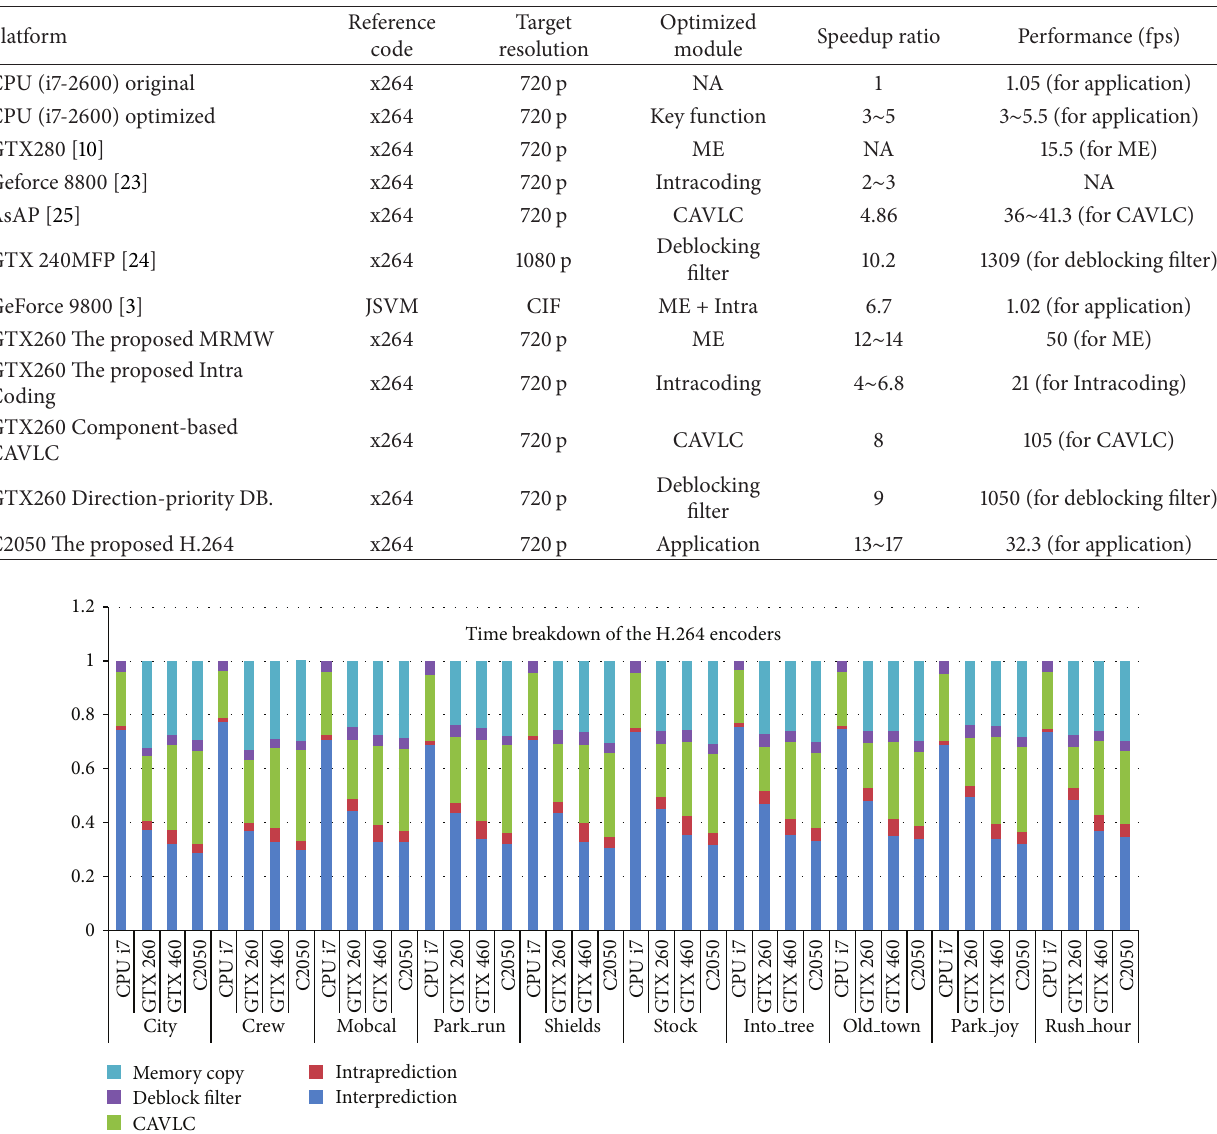
Figure 19: Time breakdown of Shields on CPU and